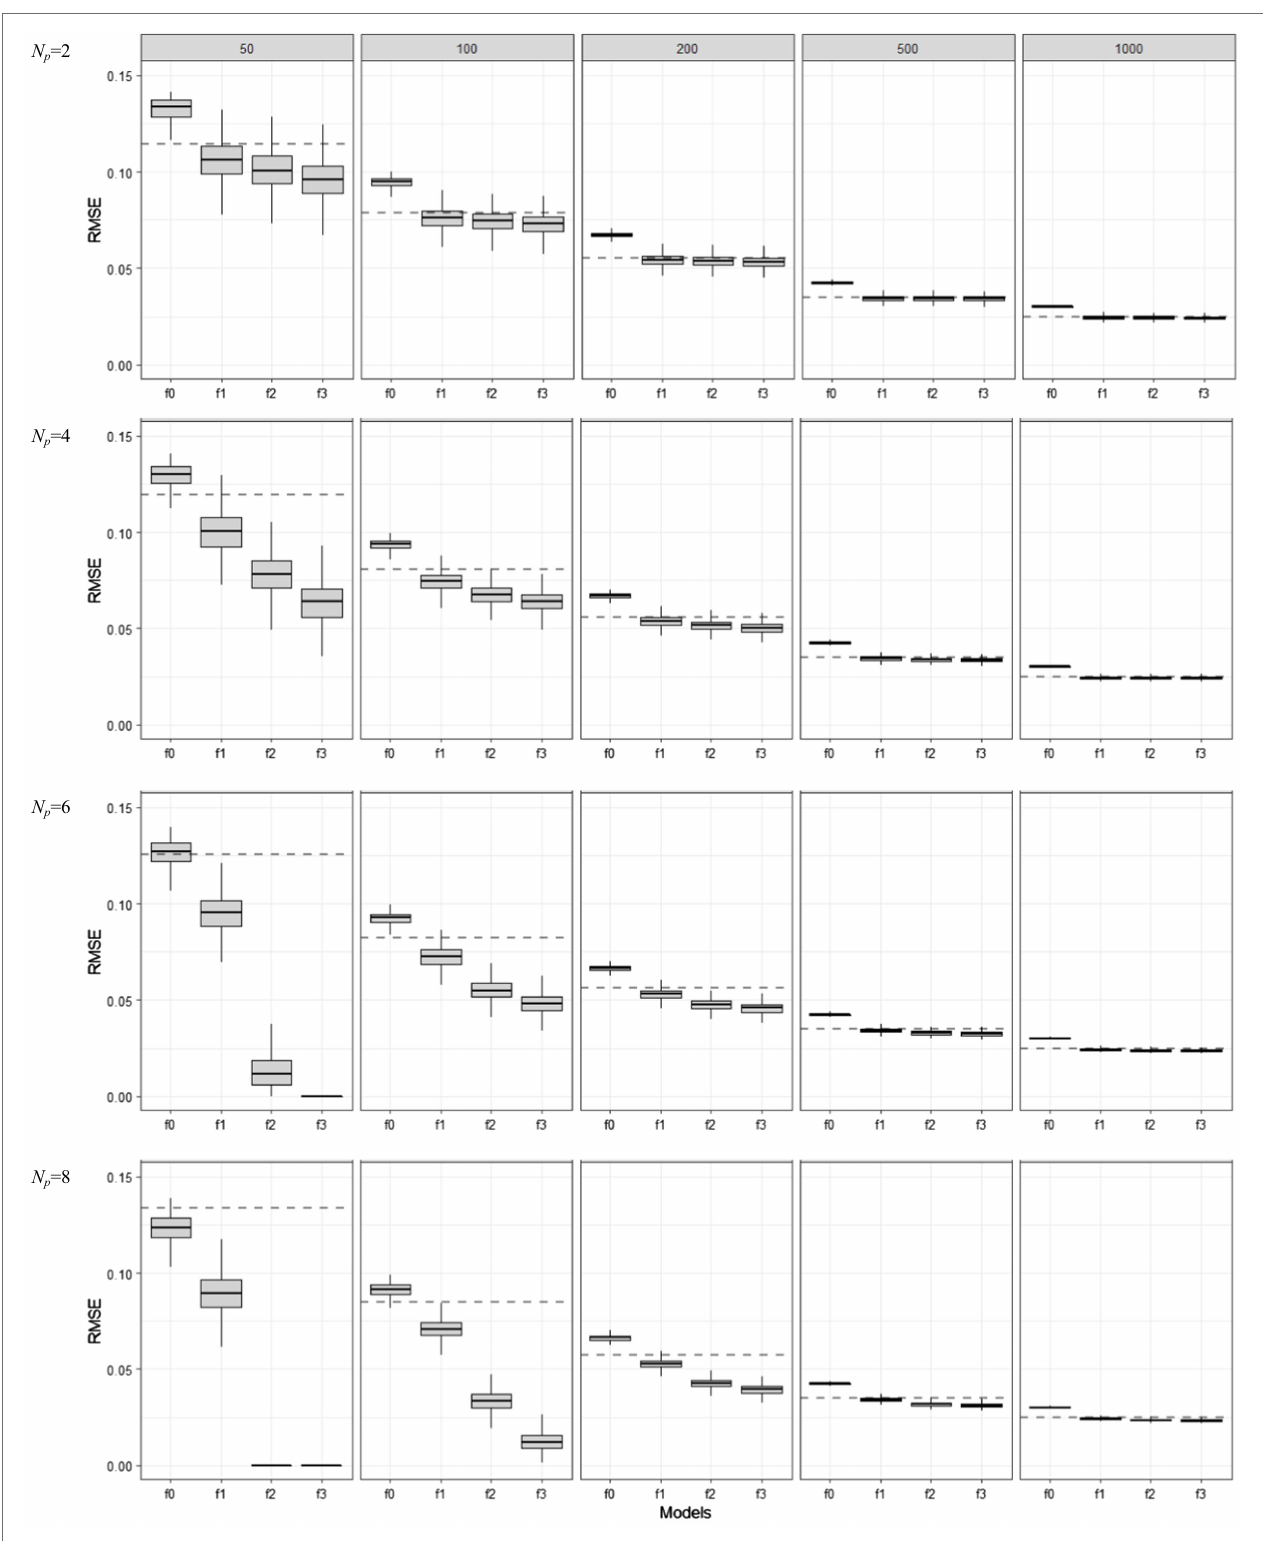
FIGURE 3 | Behavior of in-sample RMSE values as the training set sample size ( N = 50, 100, 200, 500, 1,000) and model complexity ( Np = 2, 4, 6, 8) are varied for different model mis-specification conditions (f0, f1, f2, and f3). f1 is the true model, f0 is an under-specified model, and f2 and f3 are over-specified